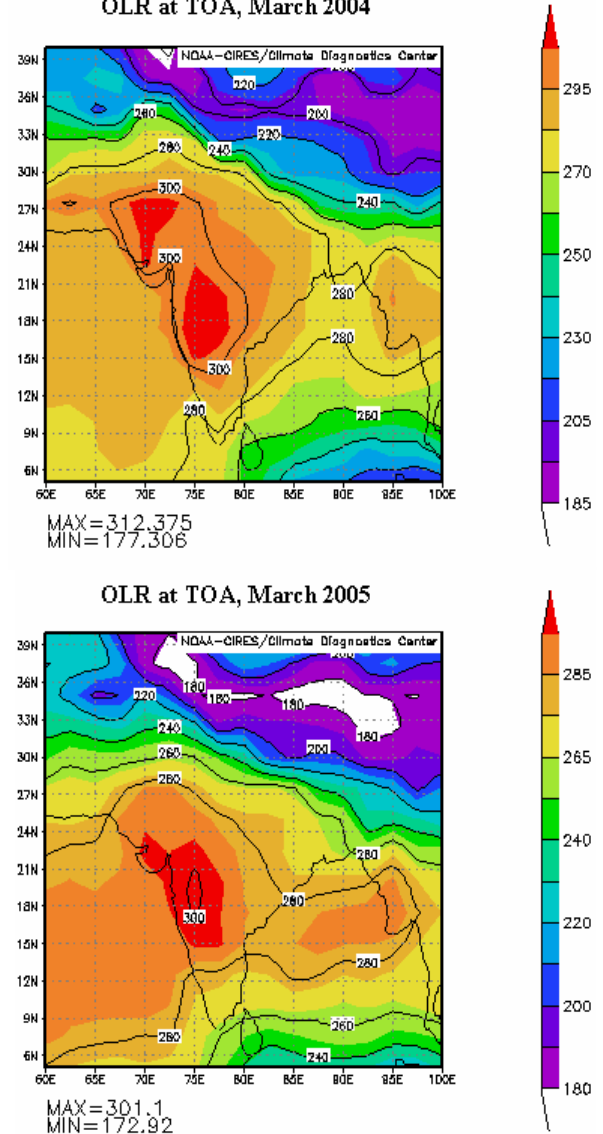
Fig. 9. Spatial distribution of monthly mean outgoing long wave radiation flux (W/m 2 ) at top of the atmosphere over the Indian sub- continent region for March 2004 (top panel) and March 2005 (bot- tom